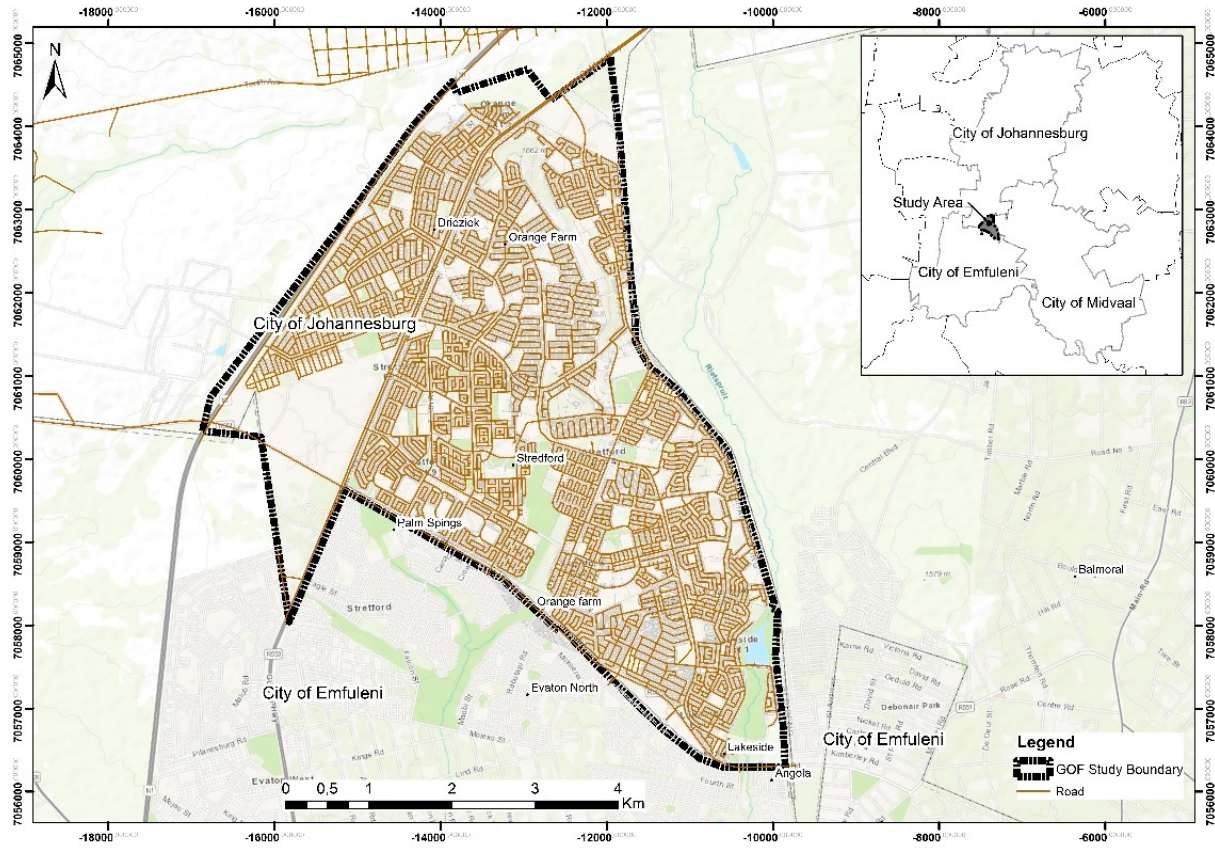
Figure 1. Location of Study Area.